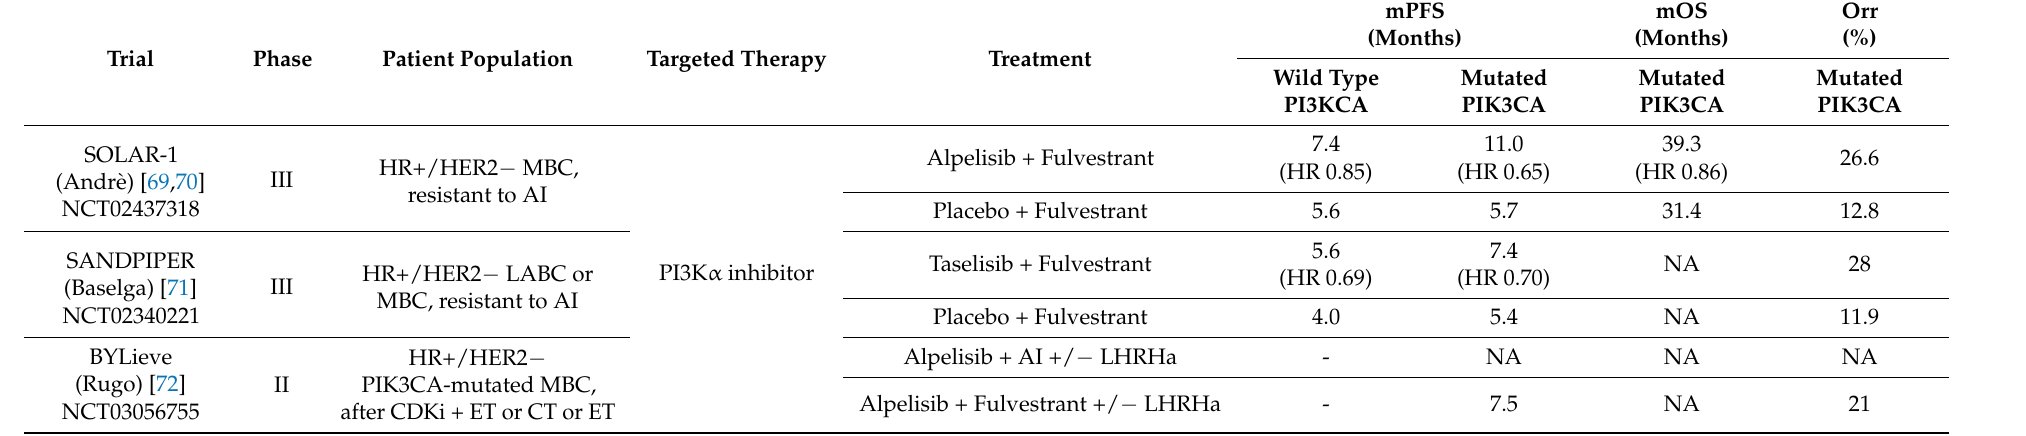
Table 2. Summary of phases II-III trials with PI3K isoform specific-inhibitors in HR-positive/HER2-negative metastatic breast